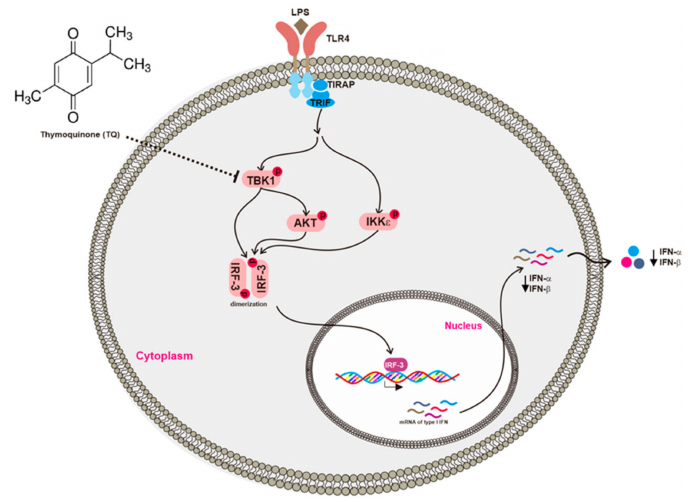
Figure 6. Putative inhibitory activity of TQ with respect to the IRF-3 pathway. TQ downregulated type I IFN by targeting TBK1, which suppressed IRF-3